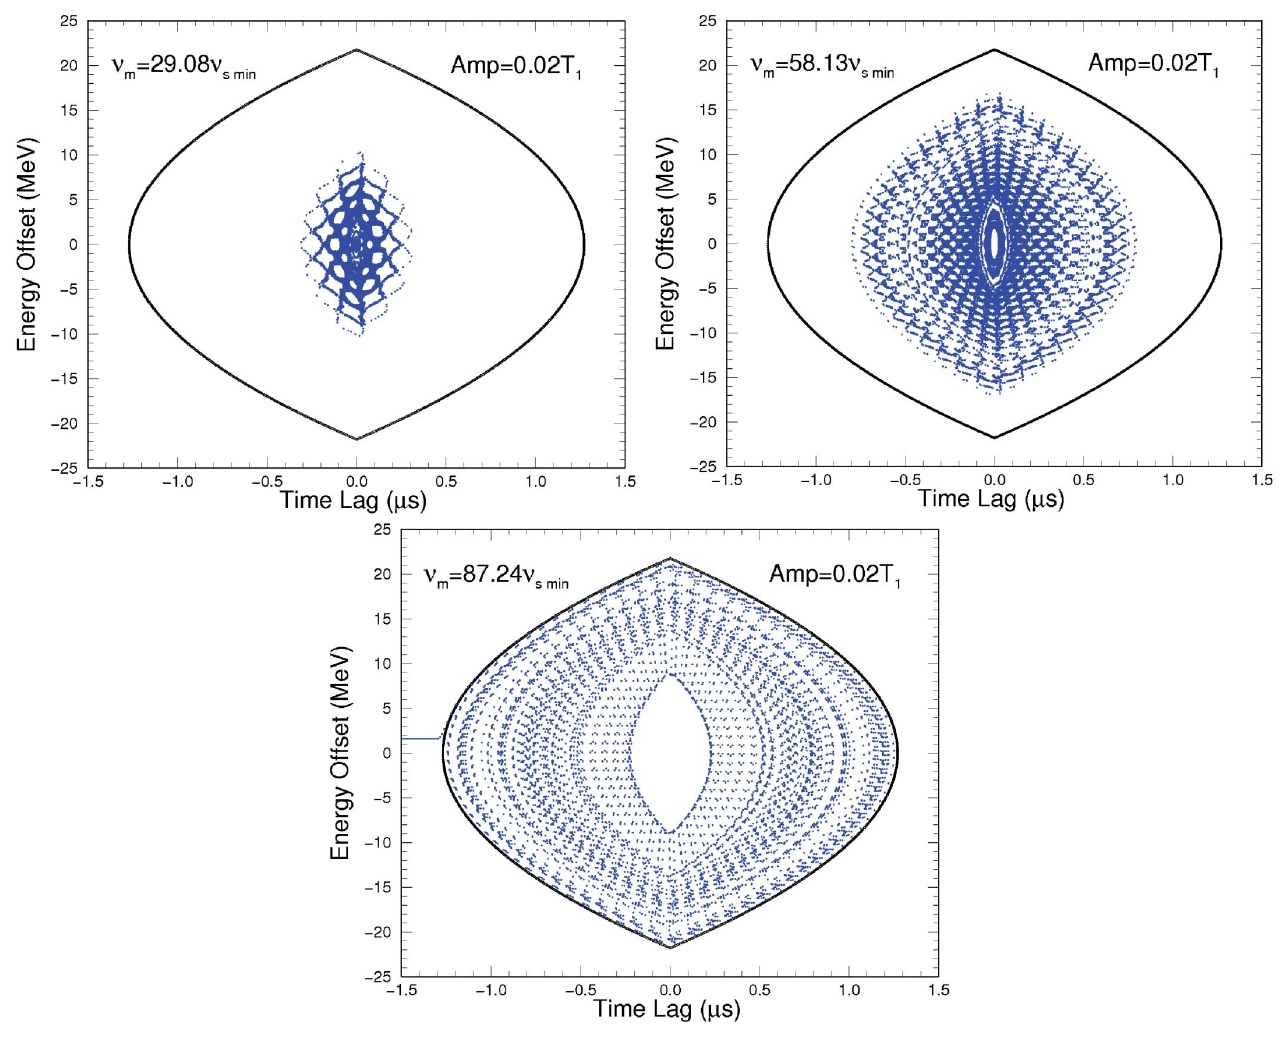
(cid:1) 29 : 08 (cid:4) (top m s; min